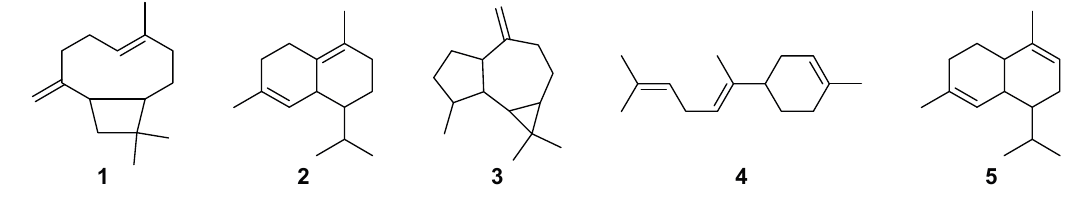
Figure 1. Chemical structures of the major constituents of Copaifera oil (COP) identified by GC-MS.